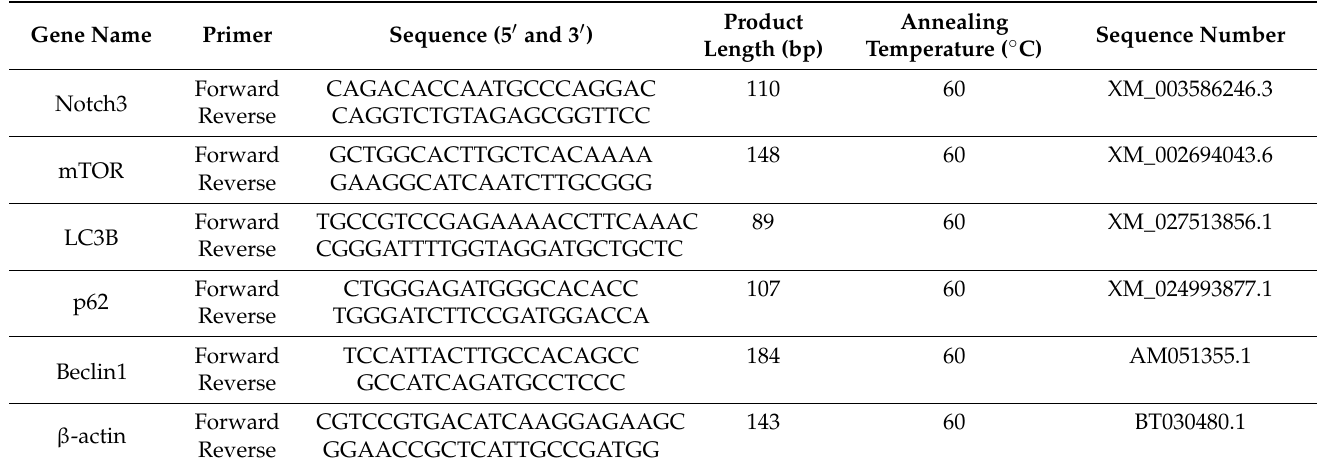
Table 1. The primers used for Real-time